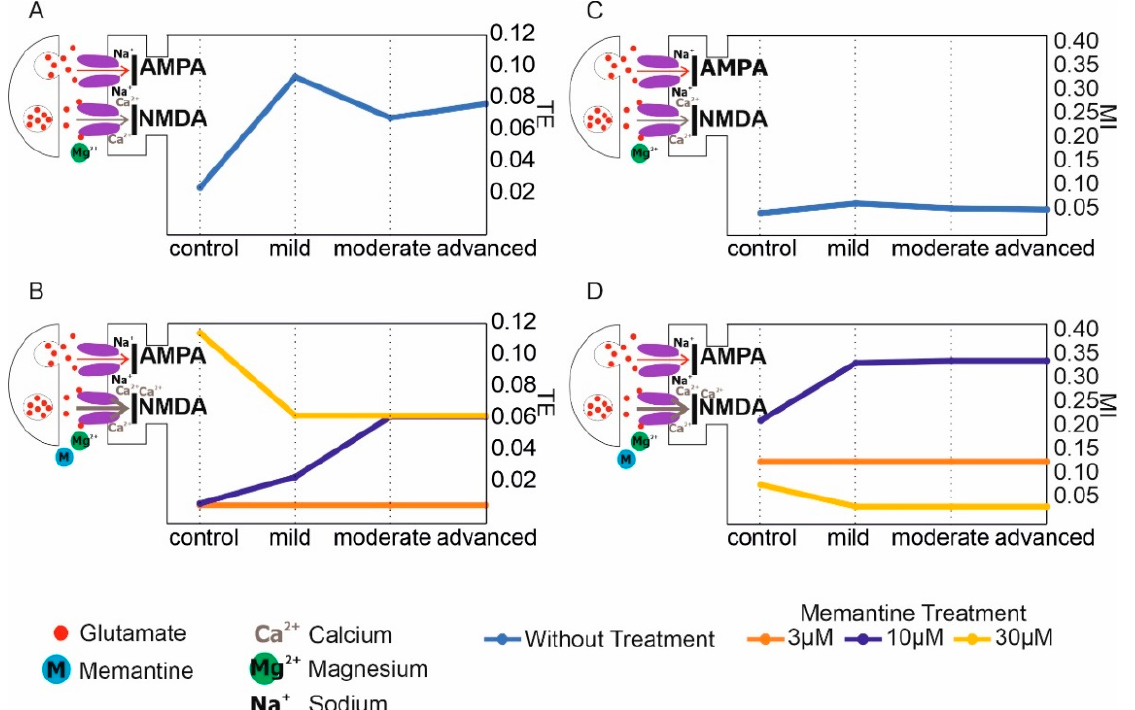
Figure 2. Synaptic transmission “as a function” of transfer entropy (TE) and mutual information (MI) in control, AD, memantine treatment models. ( A ) Transfer entropy of control and AD models. ( B ) Mutual information of control and AD models. ( C ) Transfer entropy of control and memantine treatment models at three concentrations: 3, 10, and 30 µM. ( D ) Mutual information of control and memantine treatment models at three concentrations: 3, 10, and 30 µM.